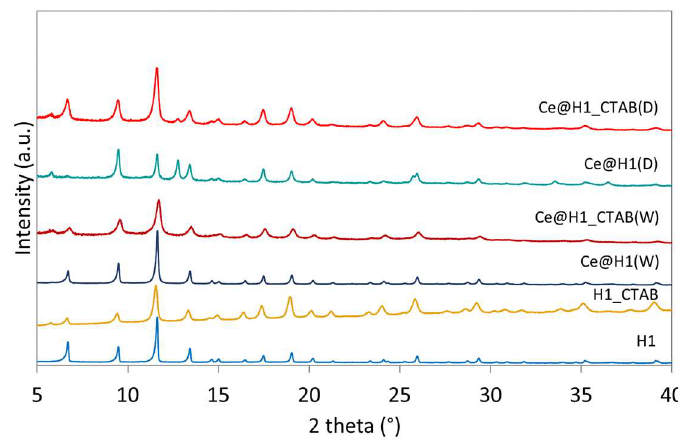
Figure 1. XRD of HKUST-1 and Ce@HKUST-1 materials (descriptions for sample names are given in Materials and Methods, i.e., in Sections 3.1 and 3.2).